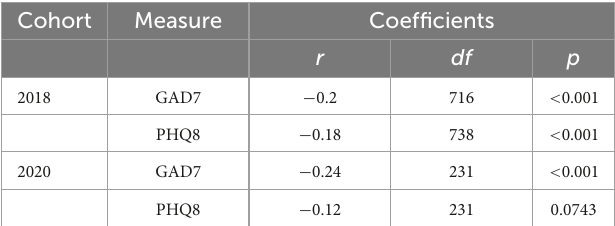
TABLE 4 Correlations of age and mental health scores for each cohort. Cohort